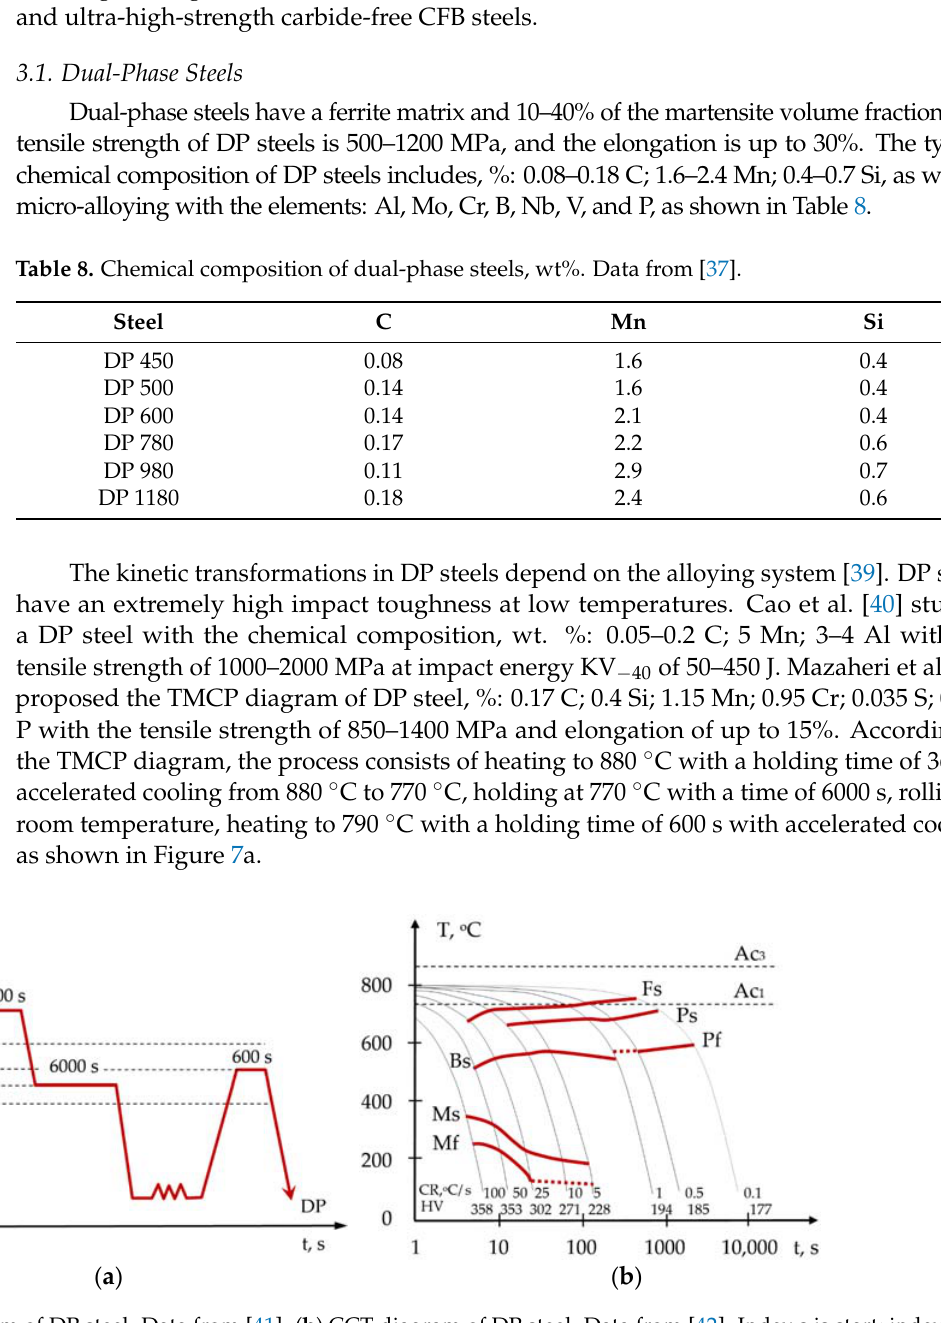
Figure 7. ( a ) TMCP diagram of DP steel. Data from [41]. ( b ) CCT diagram of DP steel. Data from [42]. Index s is start; index f is finish.